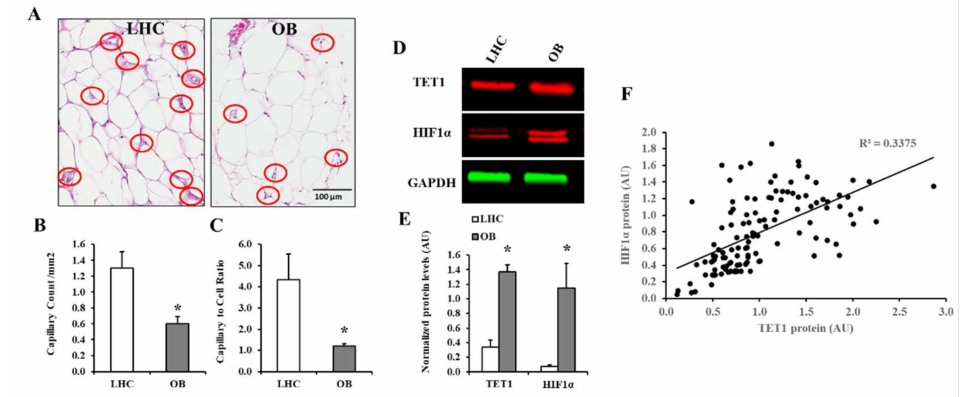
Figure 1. Adipose tissue’s vascularity and protein levels of HIF1 α and TET1. ( A ) Representative photomicrographs of adipose tissue biopsies stained with an amylase-periodic acid Schiff (PAS) histochemical stain for capillary detection. Capillaries were indicated by red circles. ( B , C ) Graphical representations of capillary count per mm 2 and capillary to cell ratio in VAT samples obtained from obese and non-obese subjects ( n = 60, each). ( D , E ) Western blot analysis and quantification of the normalized signal intensity of HIF1 α and TET1 proteins in VAT samples obtained from obese subjects and controls ( n = 60, each). ( F ) A scatter plot and Spearman correlation coefficient (r) of HIF1 α and TET1 proteins in VAT. Results are shown as means ± standard error (SE), and the * symbol reflects a p -value < 0.05 when comparing obese subjects with